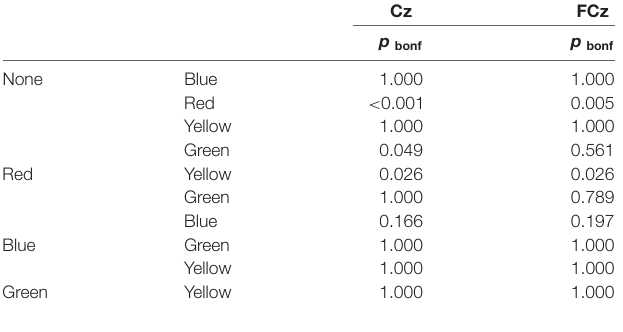
TABLE 3 | Pairwise post hoc comparisons with Bonferroni-Correction for